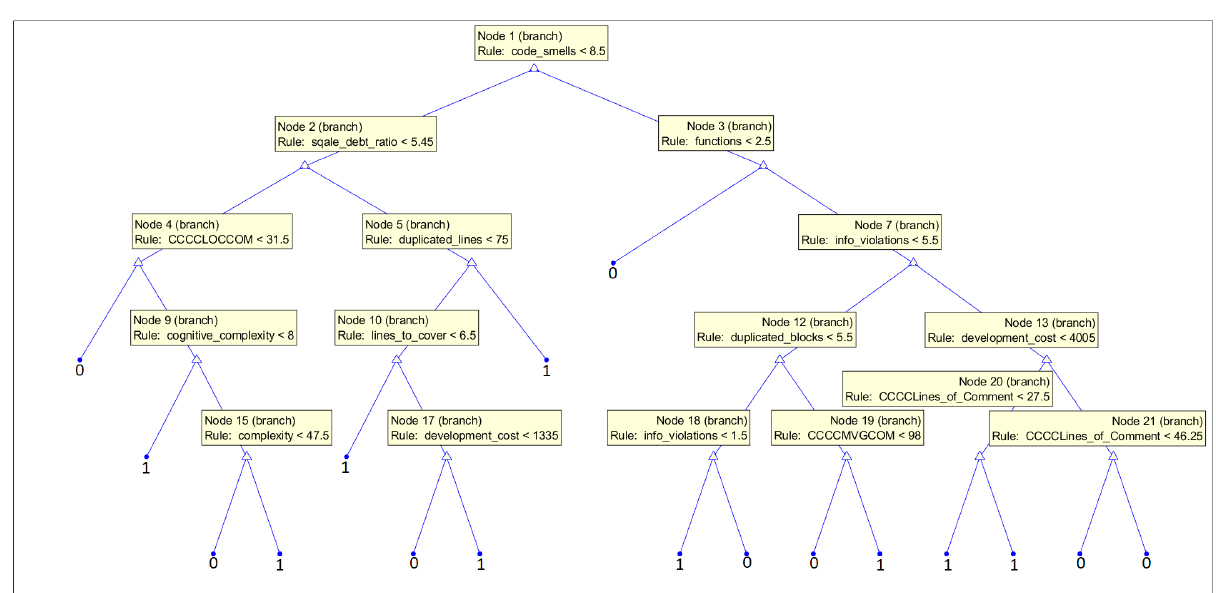
Figure 17. Medium tree based given all 33 features as an input for the subset with CWE-119 vulnerabilities